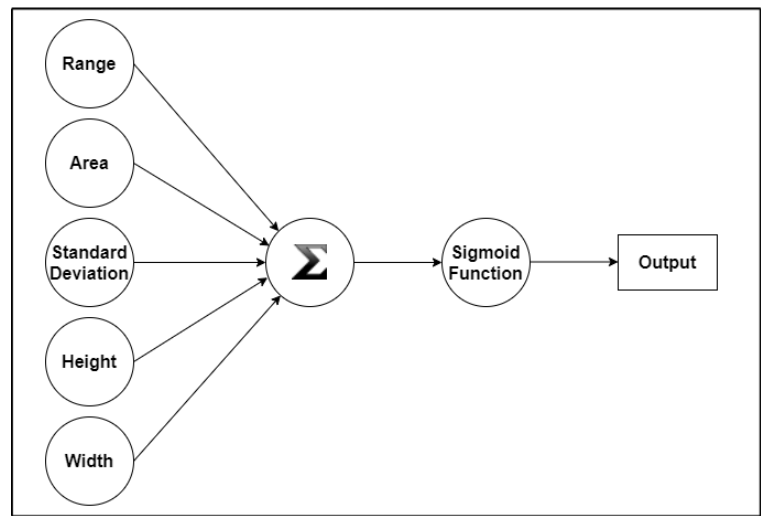
Figure 10. Logistic regression model.